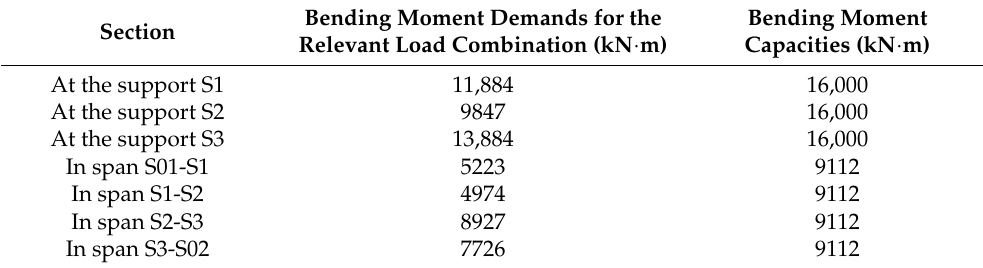
Table 2. Comparison of design bending moments with the bending moment capacities of the main longitudinal girders for the designed strengthening state.